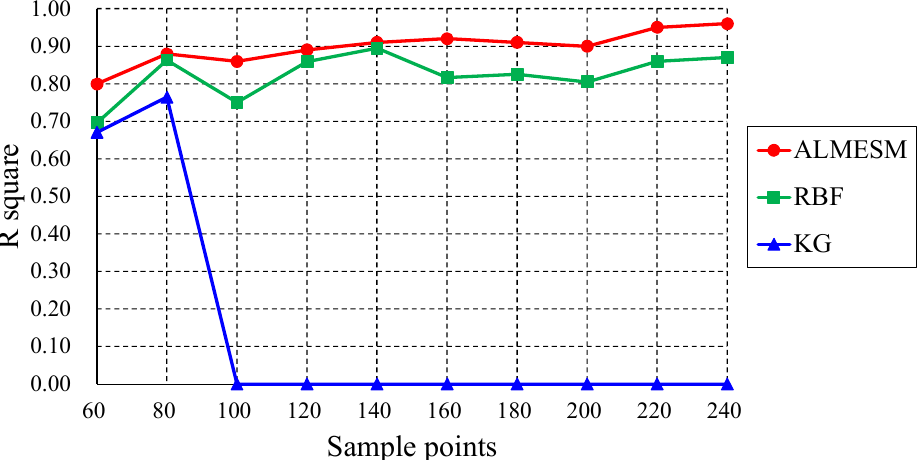
Figure 13. R-squared comparison of ALMESM, RBF, and KG under different numbers of sample points for approximating the LCF life of the GH720Li turbine disk.